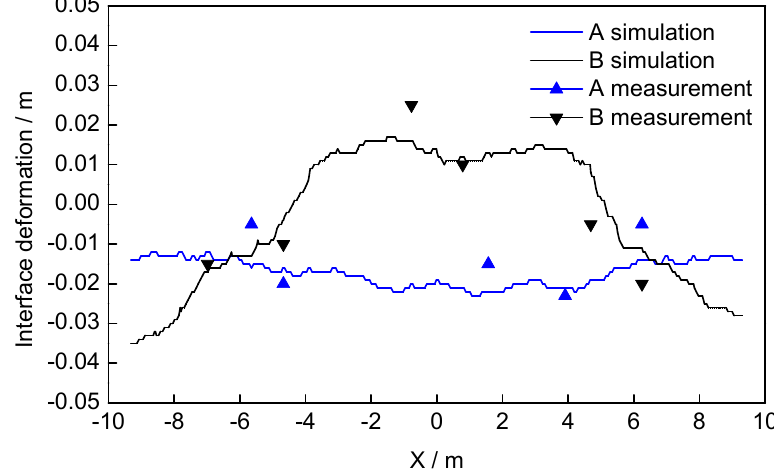
Figure 7. Comparison of interface deformation between simulation and measurement.